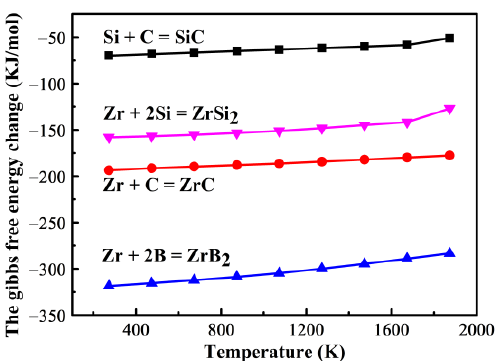
Figure 6. The Gibb’s free energy change as a function of temperature for the reaction involved in this work.